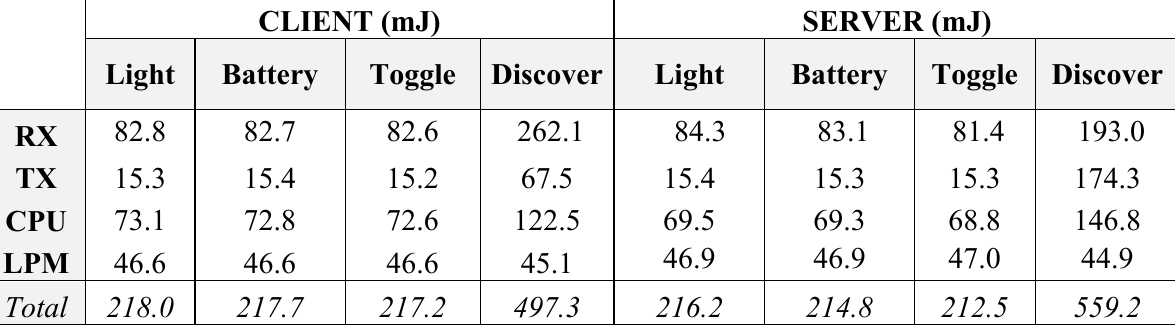
Table 6. CoAP-packet Energy Consumption calculation (ContikiMAC RDC Layer).